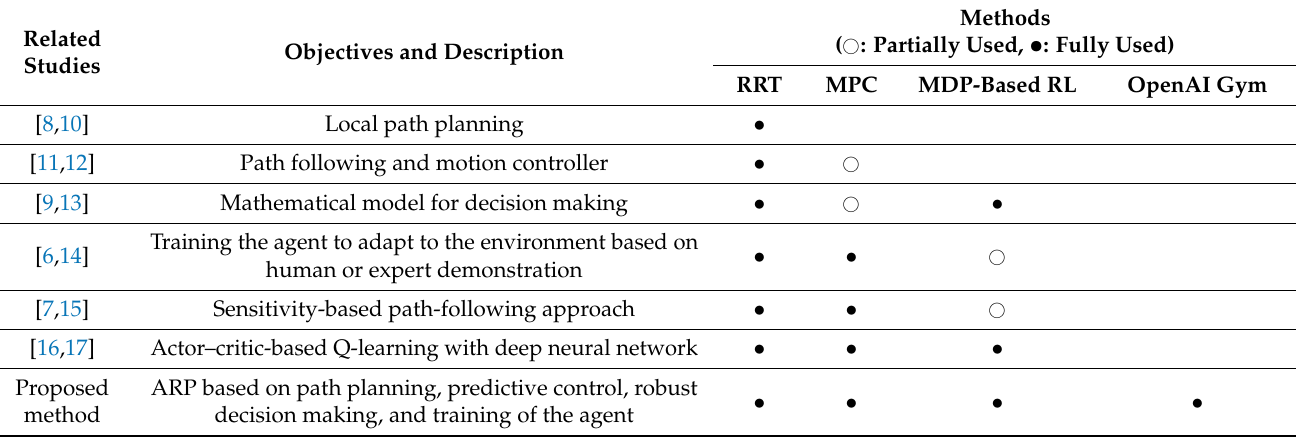
Table 1. Related studies on autonomous rear